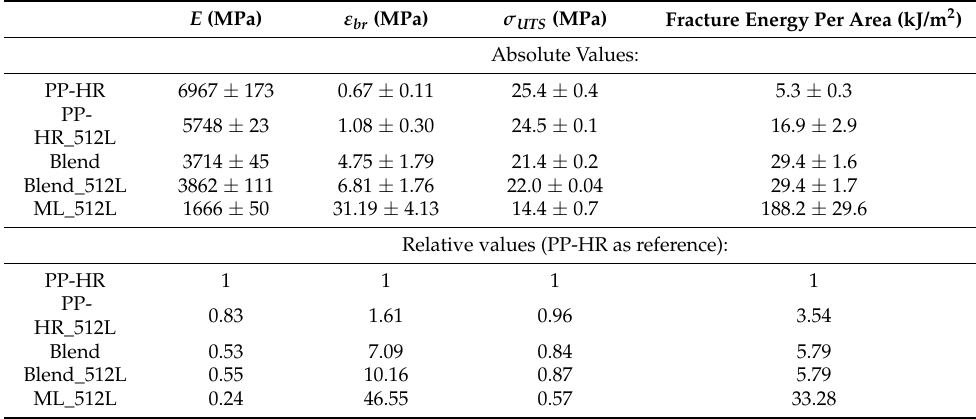
Table A2. Material parameters obtained from tensile